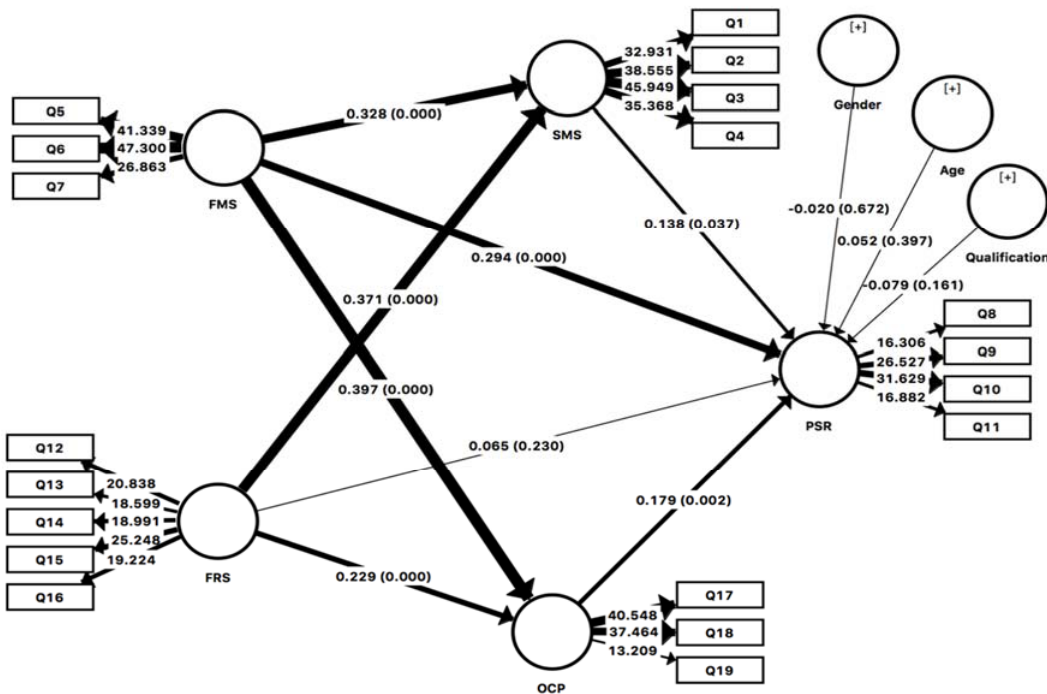
Figure 3. Path Figure 3. Path analysis.